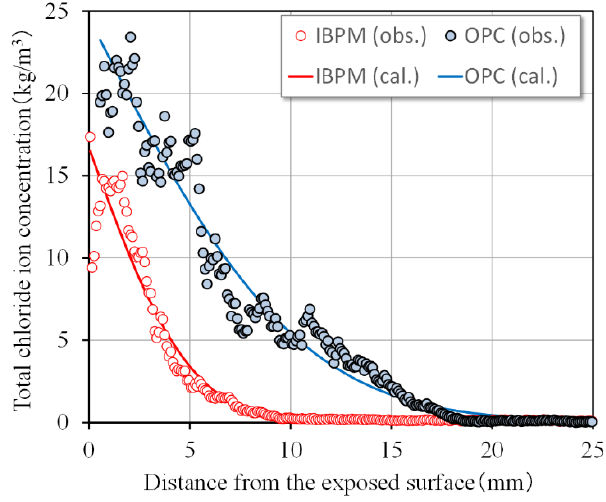
Figure 9. Chloride ion concentration profile in concrete.